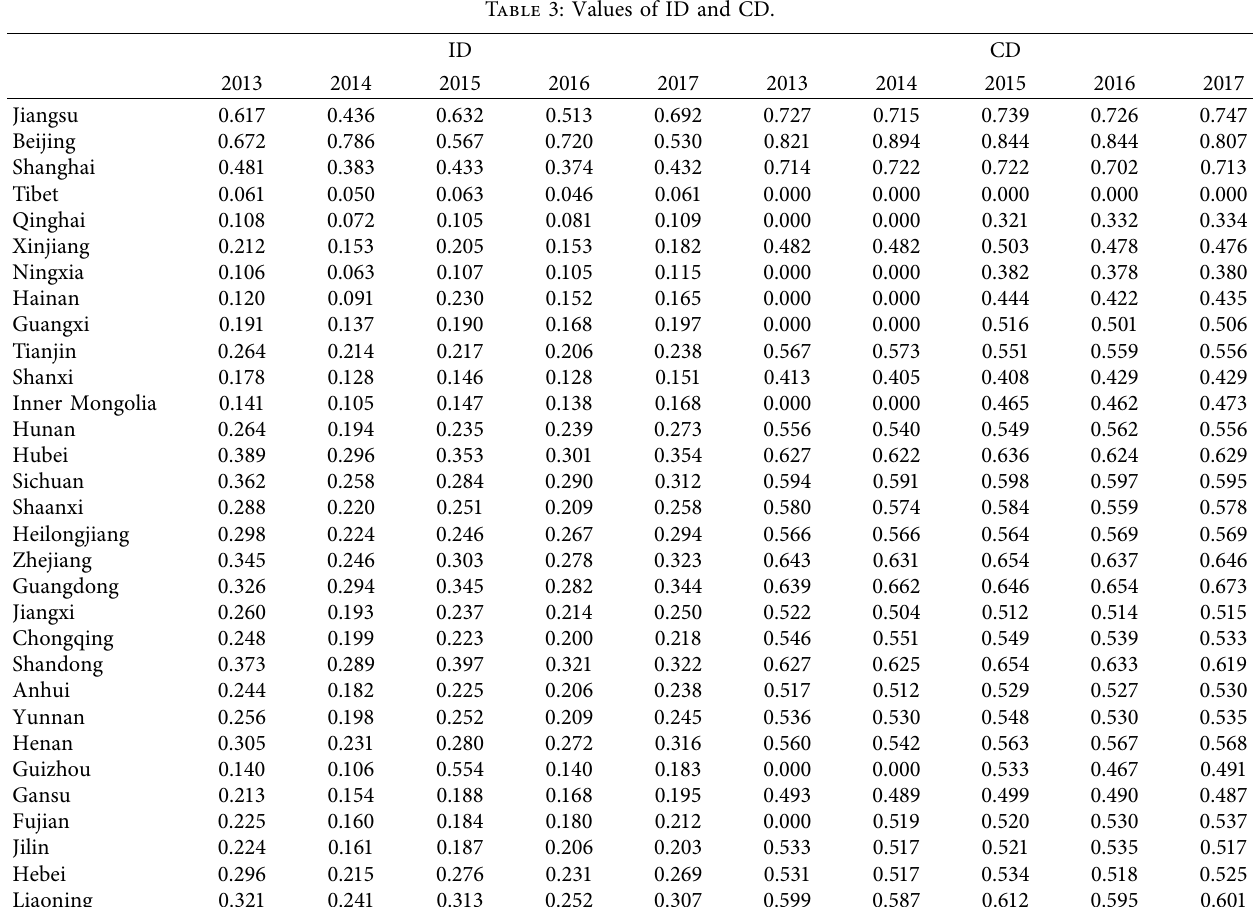
Table 3: Values of ID and